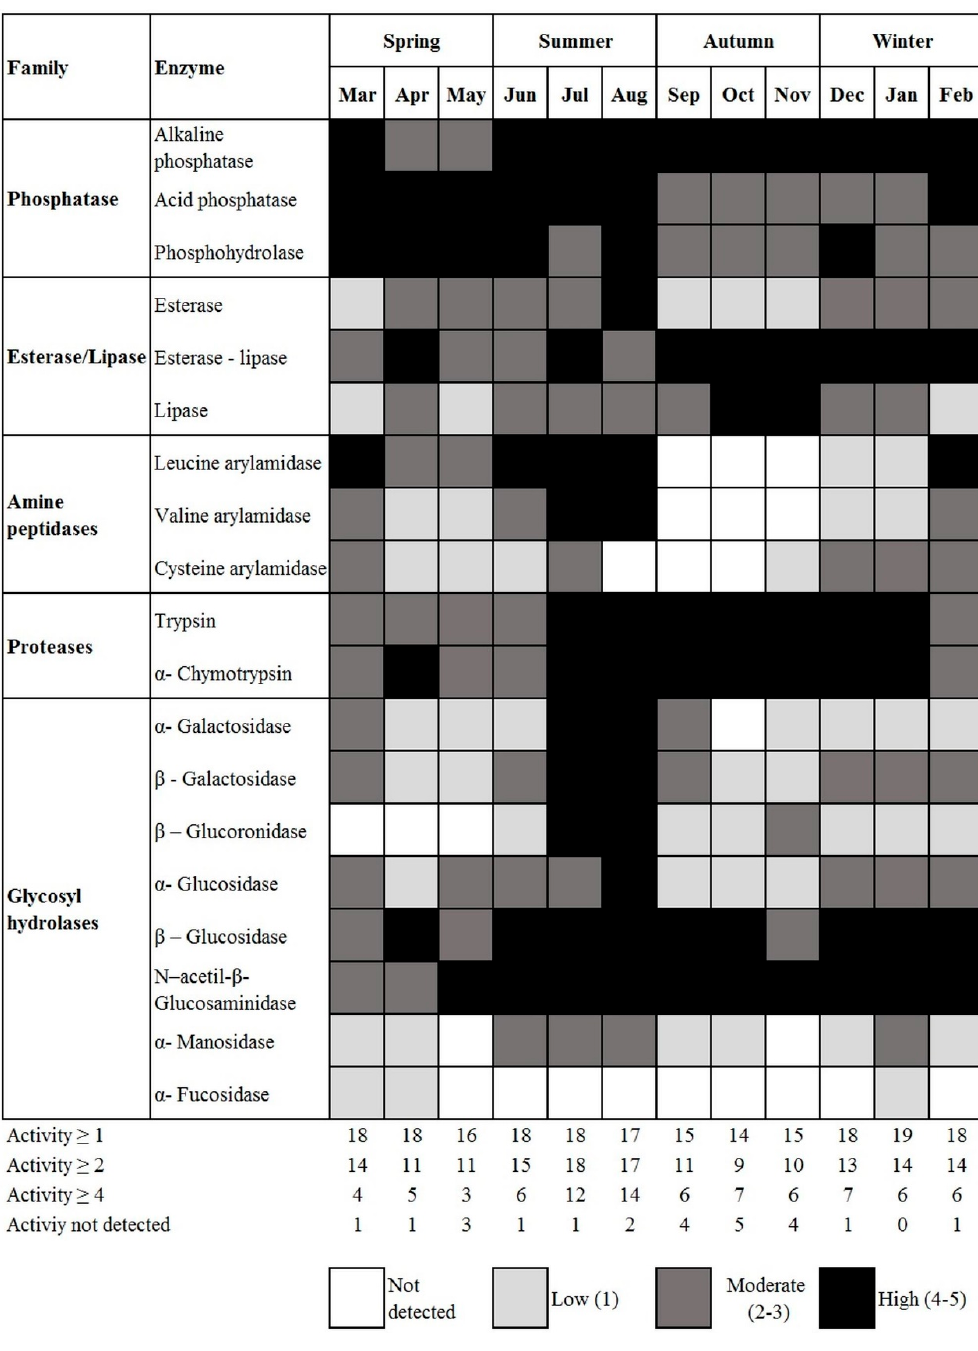
Figure 4. Profile of 19 extracellular enzymes determined by the API ZYM ® system in the biosolids analysed during one year of UWWTP operation. The shading in the table represents the relative abundance of enzymes. The values are as follows: White, not detected; light grey, low intensity reactions (value = 1); dark grey, moderate intensity reactions (value = 2 and 3); black, high intensity reactions (value = 4 and 5). The number of enzymes showing reactions ≥ 1, ≥ 2 and ≥ 4, as well as the total number of enzymes showing no activity for each month are indicated below each column.